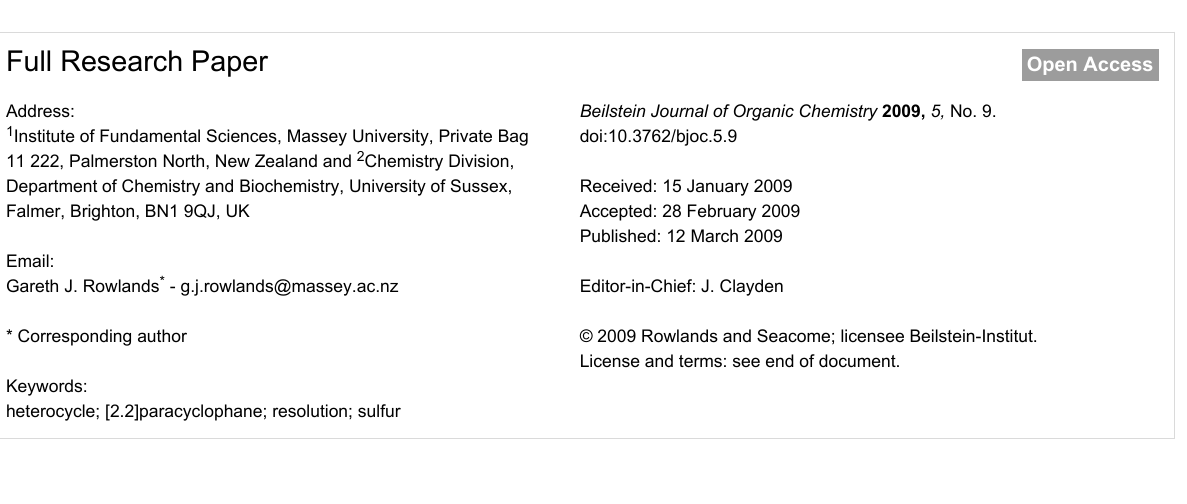
Chiral sulfur [2.2]paracyclophane derivatives are beginning to attract attention due to the great potential such compounds exhibit [16-18]. Non-cyclophane-based thiophenol